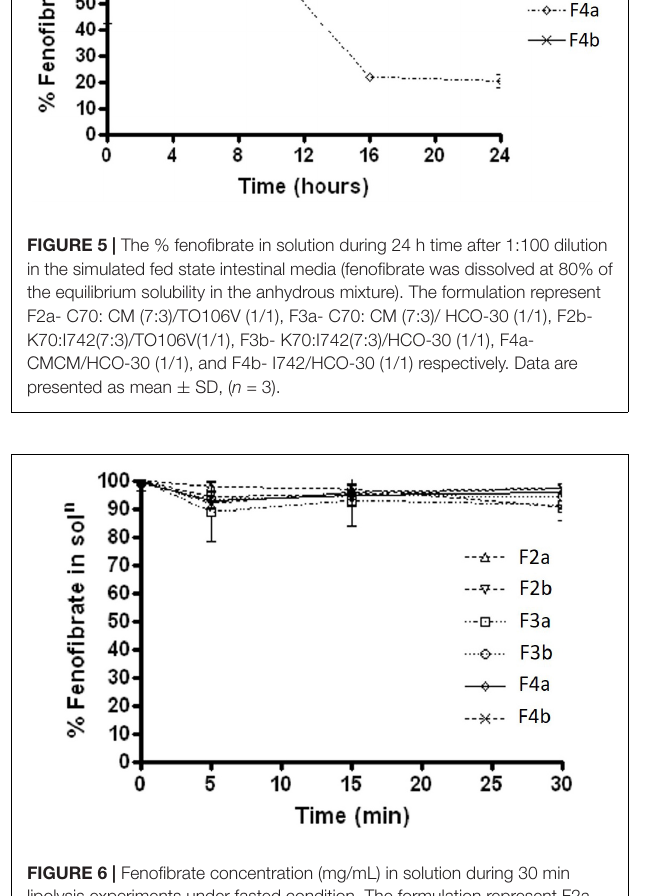
FIGURE 6 | Fenofibrate concentration (mg/mL) in solution during 30 min lipolysis experiments under fasted condition. The formulation represent F2a- C70: CM (7:3)/TO106V (1/1), F3a- C70: CM (7:3)/HCO-30 (1/1), F2b- K70:I742(7:3)/TO106V(1/1), F3b- K70:I742(7:3)/HCO-30 (1/1), F4a- CMCM/HCO-30 (1/1), and F4b- I742/ HCO-30 (1/1) respectively. Data are presented as mean ± SD, ( n = 3).